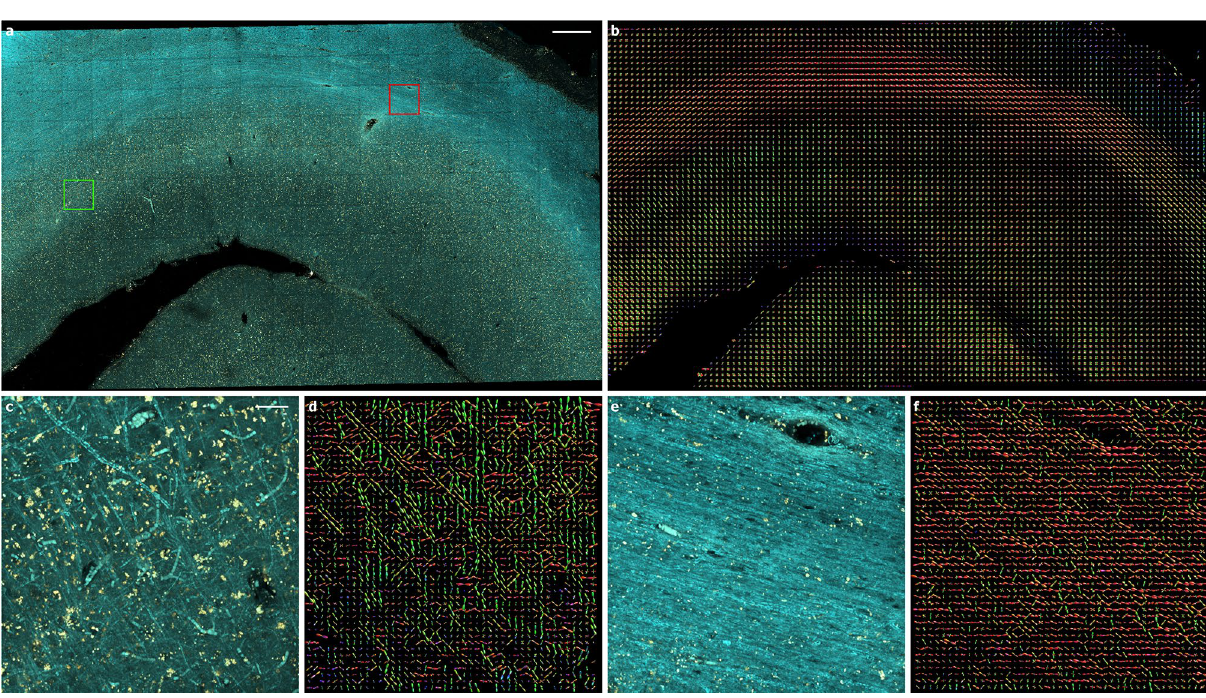
Figure 4. Frangi-based orientation analysis of myelinated fibers in a mesoscale tiled TPFM reconstruction (final stitched size: 8859.9 µ m 5204.8 µ m 98.0 µ m , acquisition time: 14h 12min) of a brain region in × × between the primary and secondary visual cortex (V1/V2): ( a ) multichannel image (fibers: (cid:31) = 482 nm, cell bodies: (cid:31) = 618 nm) aligned and fused using ZetaStitcher (scale bar: 0.5 mm) 28,29 , following the uneven illumination correction achieved via the CIDRE method 30 ; ( b ) myelinated fiber ODF map ( (cid:31) = 482 nm) returned by the image processing pipeline ( α = 0.001, β = 1, scales = 1.25, 2.5 µ m ; ODF super-voxel: 80 µ m × 80 µ m 80 µ m ); ( c ) MIP of a 10 µ m -deep section including grey matter (green square, scale bar: 50 µ m ); ( d ) × corresponding grey matter ODFs (super-voxel: 10 µ m 10 µ m 10 µ m ); ( e ) MIP of a 10 µ m -deep section × × including white matter (red square); ( f ) corresponding white matter ODFs (super-voxel: 10 µ m 10 µ m × × 10 µ m ). Fiber ODF maps were displayed using the open-source software package for medical image processing and visualisation MRtrix3 31